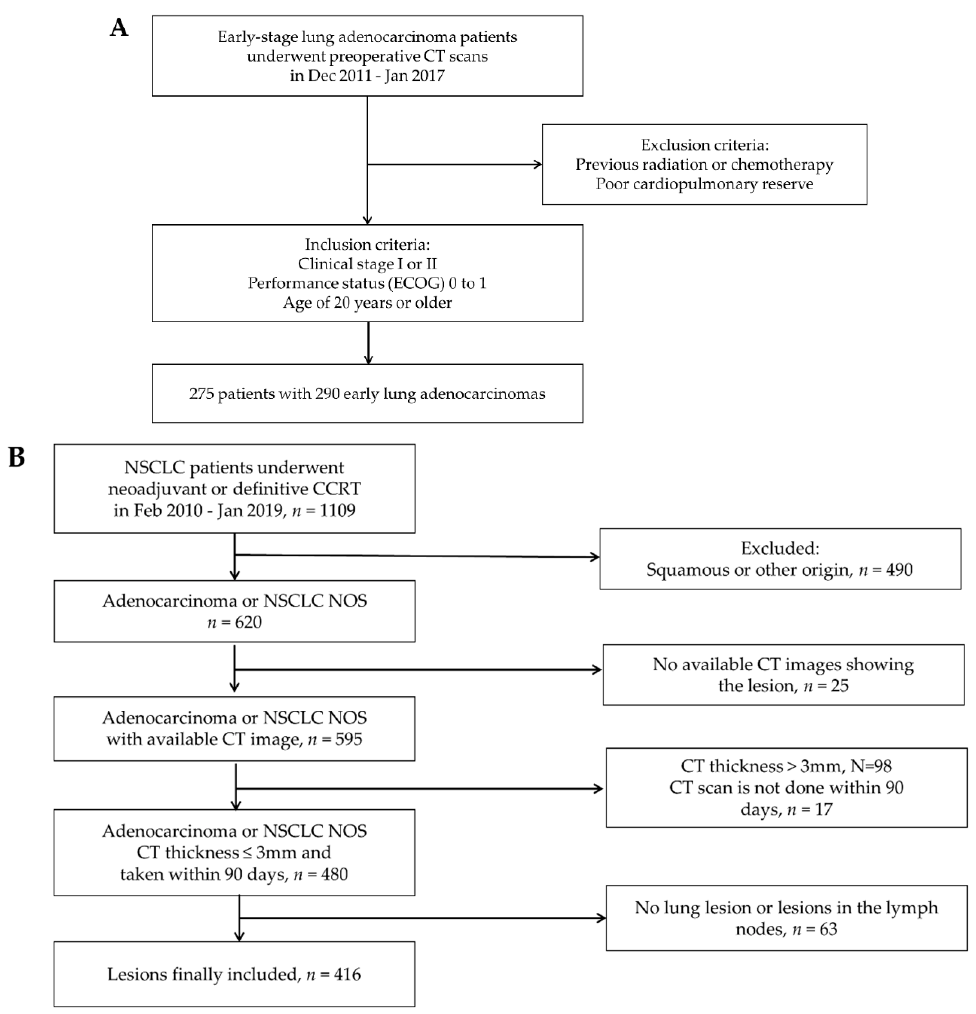
Figure 1. Patient inclusion process. ( A ) Inclusion criteria for the training data set. ( B ) Inclusion criteria for the validation data set.